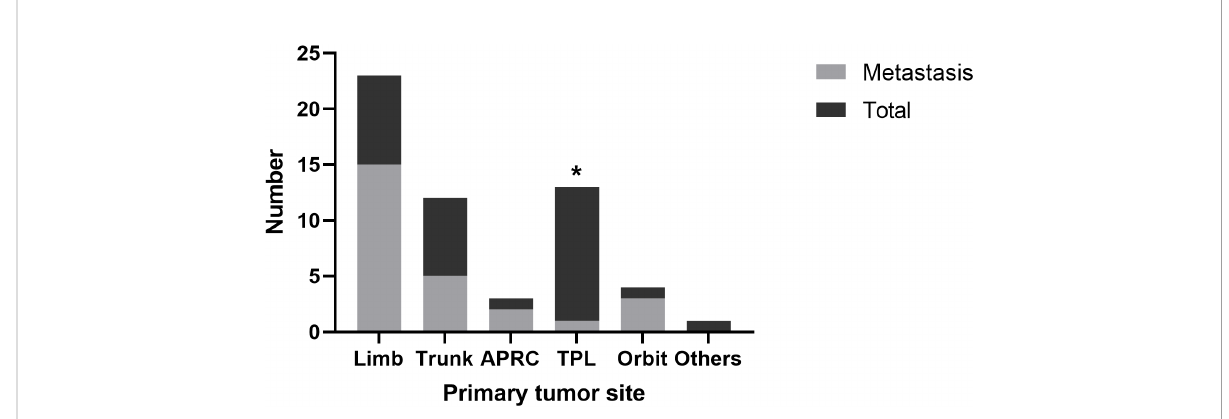
FIGURE 1 Tumor metastasis from different origin. APRC, abdominal, pelvic and retroperitoneal cavity; TPL, tongue, pharynx and